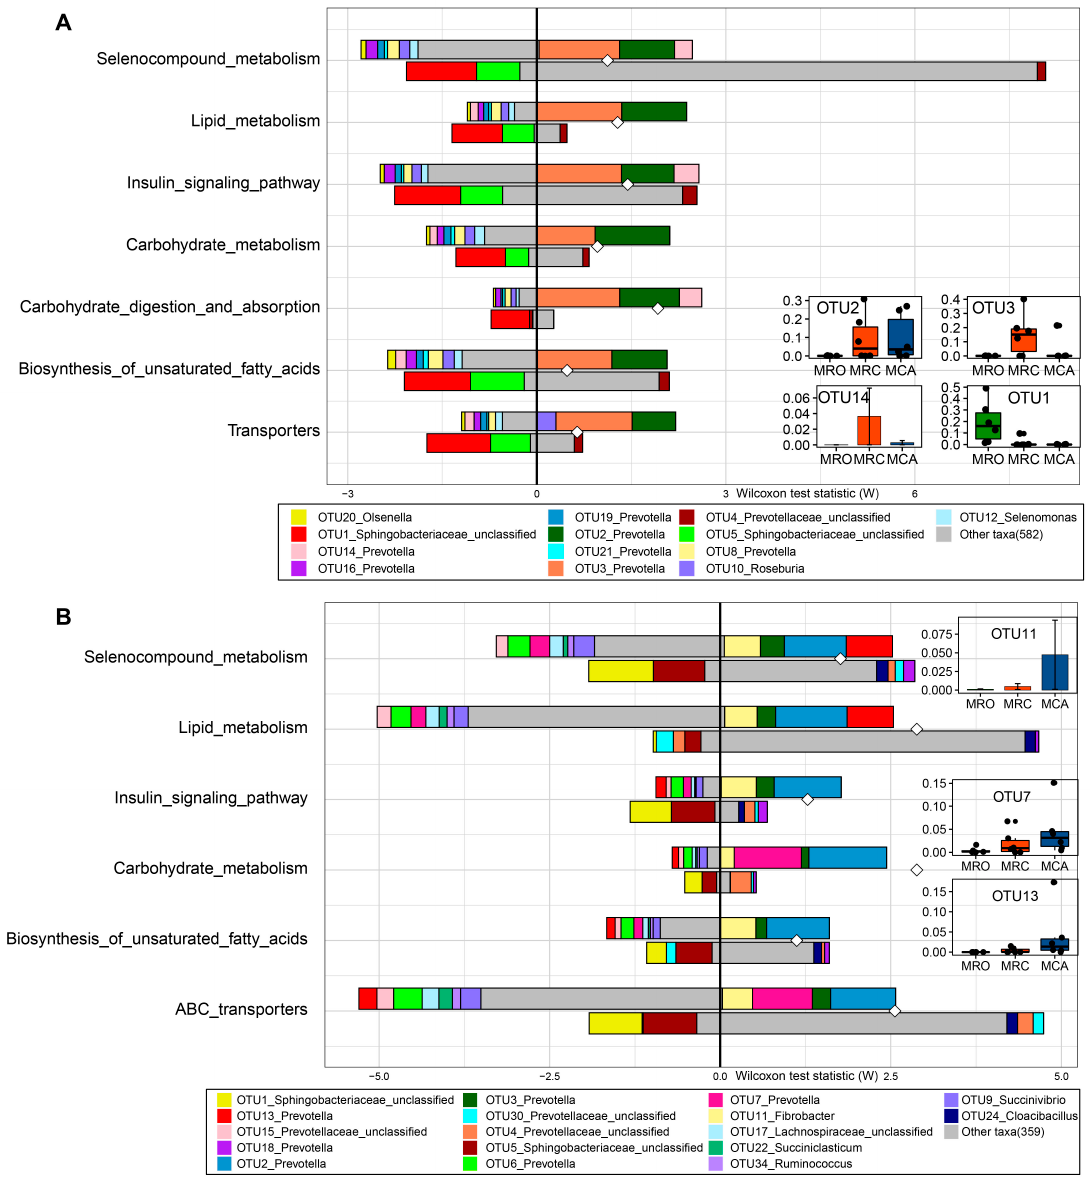
Figure 5. Comparing taxon-level contribution profiles of functional shifts. A : The driver OTUs including OTU2, OTU3, OTU14 and OTU1 altered rumen functions when defined MRO as control and MRC as case, B : Regarding MRO as control and MCA as case, the OTU11, OTU2, OTU7 and OTU13 drove the rumen functions shifts. Taxon-level shift contribution profiles for case-associated functional modules by Fish Taco. The horizontal axis represents rank and statistic scores, and the vertical axis represents related pathways. For each functional pathway, the bar on the top-right of Y axis represents case-associated bacteria driving the enrichment in the functional module; the bar on the top-left of Y axis indicates case-associated bacteria attenuating functional shift; the bar on the bottom-right of Y axis represents bacteria depleted in control driving functional shift; the bar on the bottom-left of Y axis shows bacteria depleted in control attenuating functional shift. White diamonds represent bacterial-based functional shift scores. The abundances of main drivers were displayed on the right side. OTU2 and OTU3, the shared drivers of enrichments of MRC and MCA were abundant in solid diet regimes. OTU1 enriched in MRO was strongly depleted by solid diets. OTU11, OTU7 and OTU13, driving mainly MCA function shifts, increased abundance with supplementation of solid diet. FishTaco: Functional Shifts’ Taxonomic Contributors; MRO = milk replacer; MRC = milk replacer + concentrate, MCA = milk replacer + concentrate +